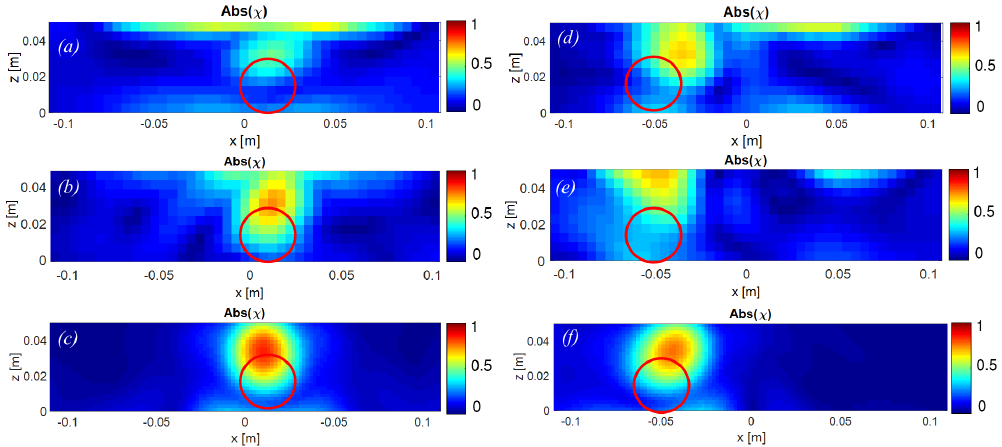
Figure 14. Reconstructed images for the contrast χ (cid:101) using ( a ) measurement; regular cable, ball located at x = 0.01 m ( b ) measurement; phase-stable cable, ball located at x = 0.01 m ( c ) simulation, ball located at x = 0.01 m, ( d ) measurement; regular cable, ball located at x = − 0.05 m, ( e ) measurement; phase-stable cable, ball located at x = 0.01 m ( f ) simulation, ball located at x = − 0.05 m. The values of the contrast are normalized with respect to the maximum value in each